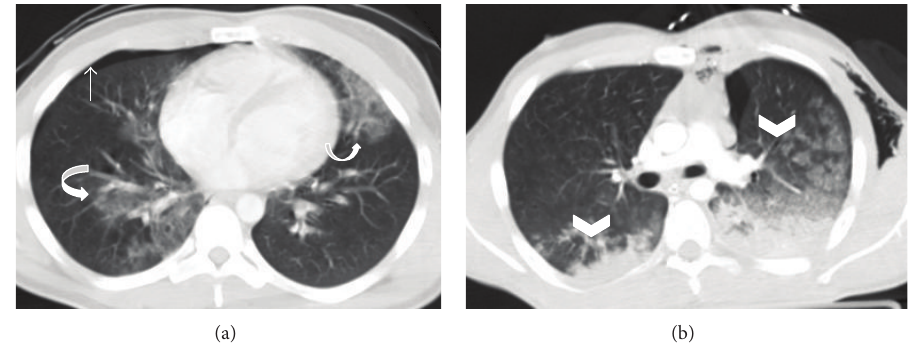
Figure 1: Bilateral pulmonary contusion. Axial MDCT in lung window reveals (a) ill-defined nonsegmental areas of “ground glass” attenuation in middle lobe, right inferior lobe, and lingula in a polytraumatized patient, consistent with bilateral contusion focus (curved arrows). Also note a small right pneumothorax (straight arrow). Axial MDCT of another patient (b) shows “ground glass” lung contusions (arrowheads) and bilateral nonsegmental air space consolidations with a posterior distribution due to blood filling of the alveolar spaces.